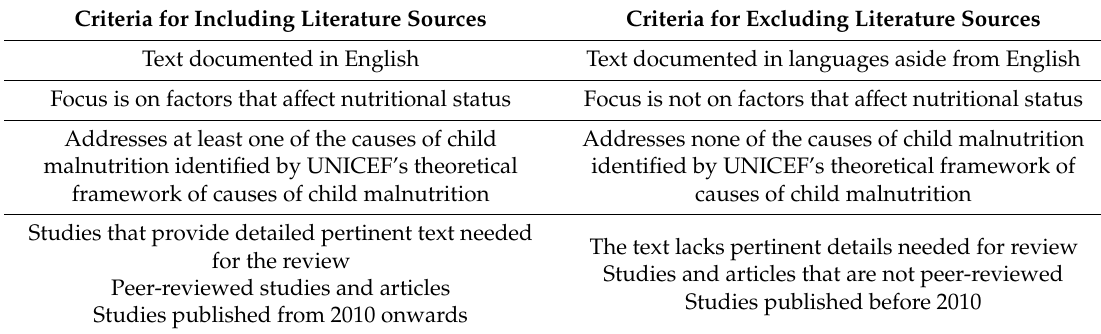
Table 1. Criteria for inclusion and exclusion of literature sources selected for